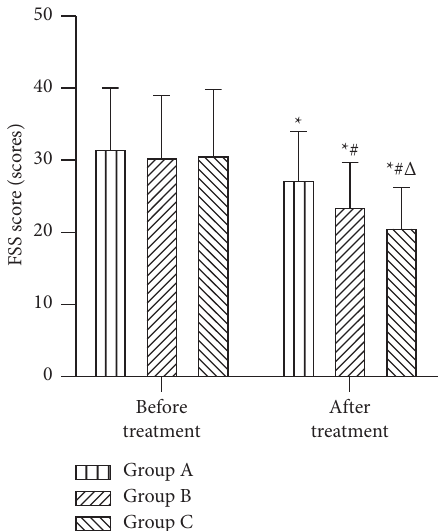
Figure 6: Comparison of 3 groups of FSS scores ( x ± s , scores). Compared with the same group before treatment, ∗ P < 0 . 05; compared with group A after treatment, # P < 0 . 05; compared with group B after treatment, Δ P < 0 . 05.